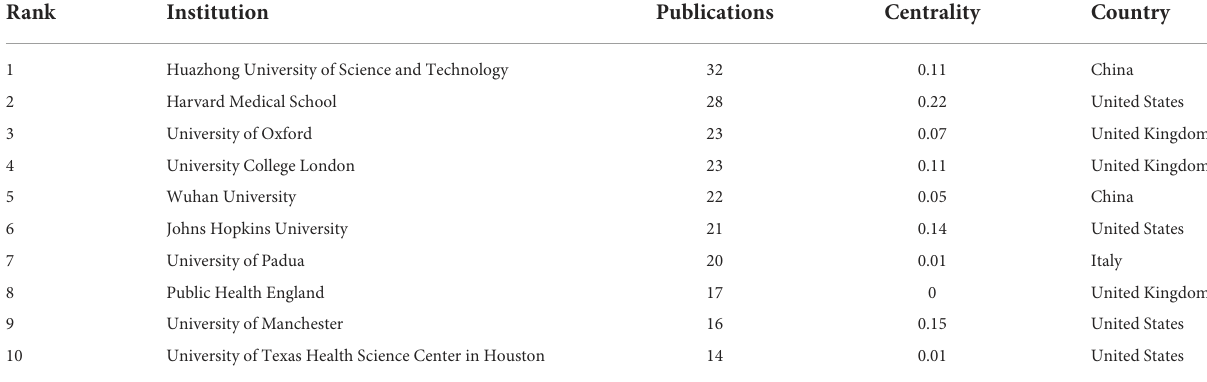
TABLE 2 Top 10 institutions publishing research articles.